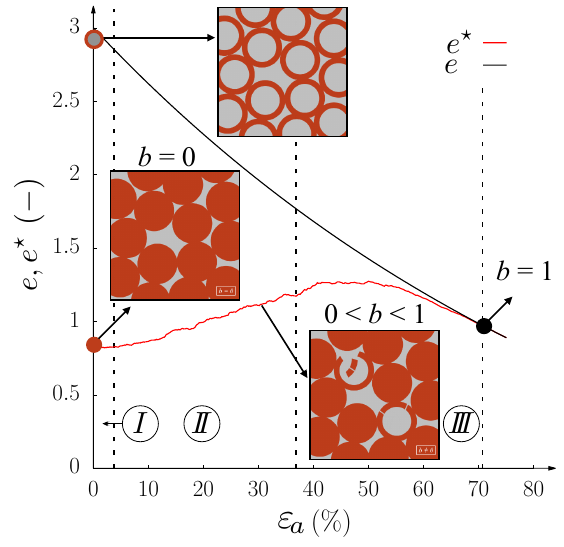
Figure 4. Void ratio evolution; Eq. (3) and modified void ratio e ? ; Eq. (4) based on breakage level with respect to vertical strains (large strain